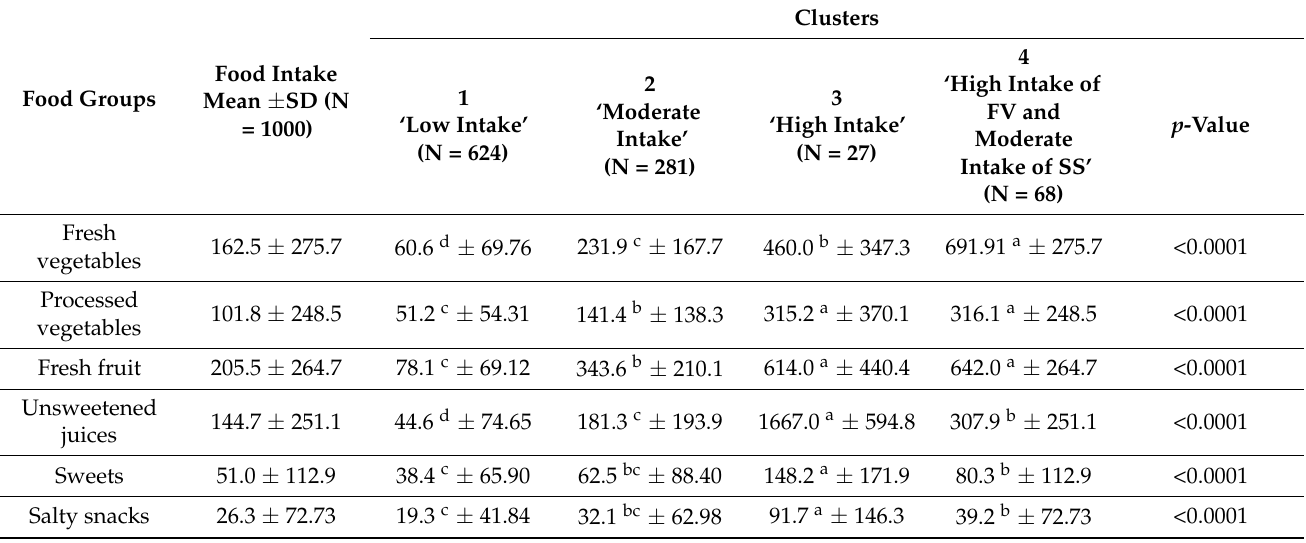
Table 8. Clusters’ profile according to the amount of food consumed.